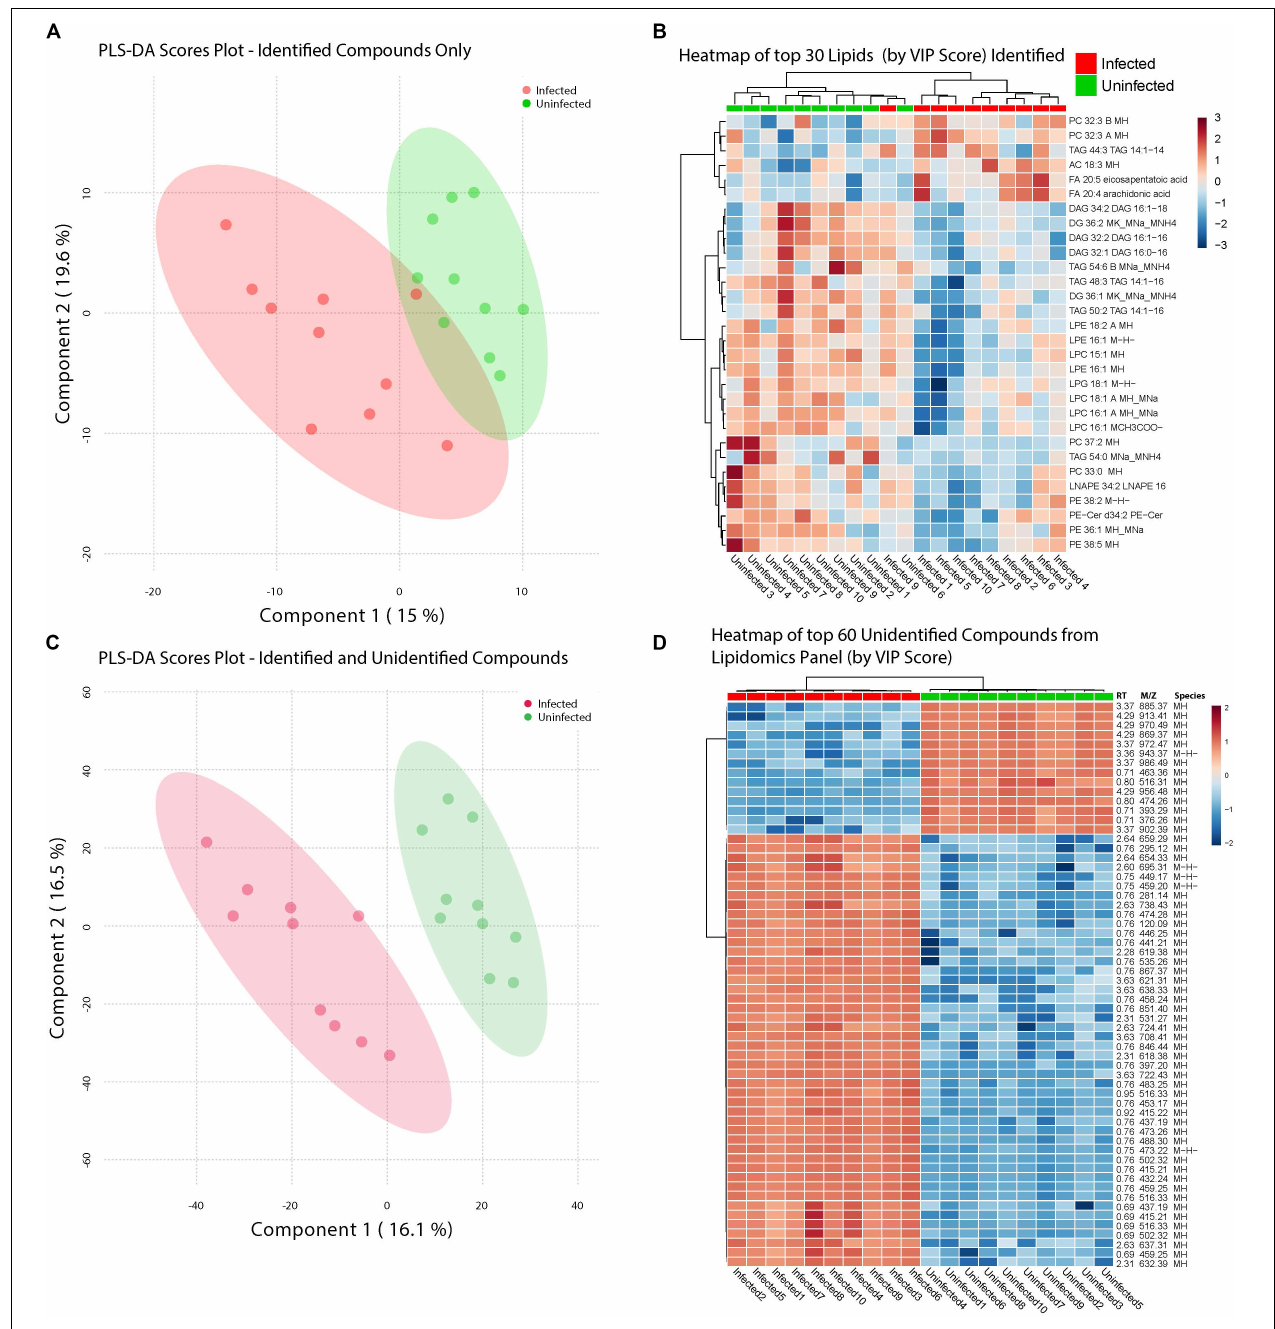
FIGURE 4 | ZIKV-infection results in alteration of the Lipid homeostasis in infected Ae. albopictus . The lipid levels alteration due to ZIKV infection were analyzed by multivariate comparative analysis using partial least squares discriminant analysis (PLS-DA). (A) Biplot of components 1 and 2 of analysis including LC-MS identified compounds only. (B) Heatmap of top 30 identified lipids as determined by VIP score. (C) Biplot of components 1 and 2 of analysis including all detected compounds. (D) Top 60 compounds (identified and unidentified) as determined by VIP score from LC-MS based lipidomics panel. Unidentified compounds are labeled by m/z (mass/charge ratio) and RT (retention time) and species. Heatmap aesthetics are equivalent to those in Figure 1